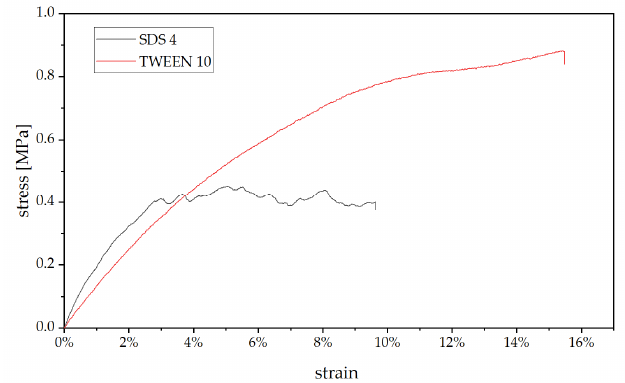
Figure 5. Stress-strain graph for SDS 4 and TWEEN 10.